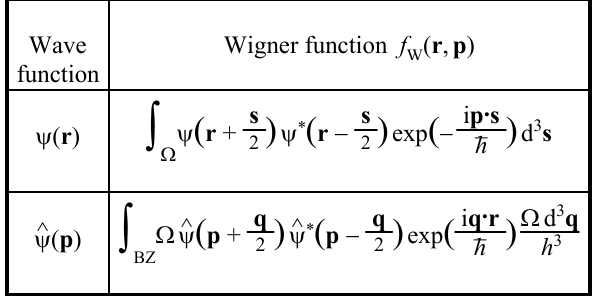
from the wave W